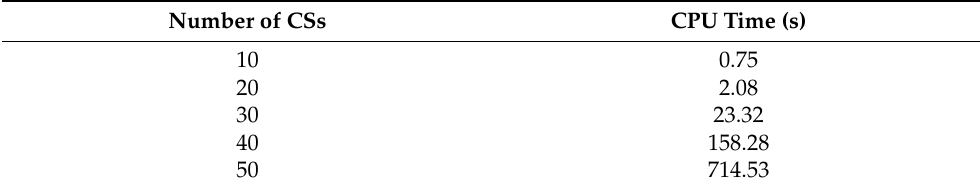
Table 4. The computing time for different scale instance.